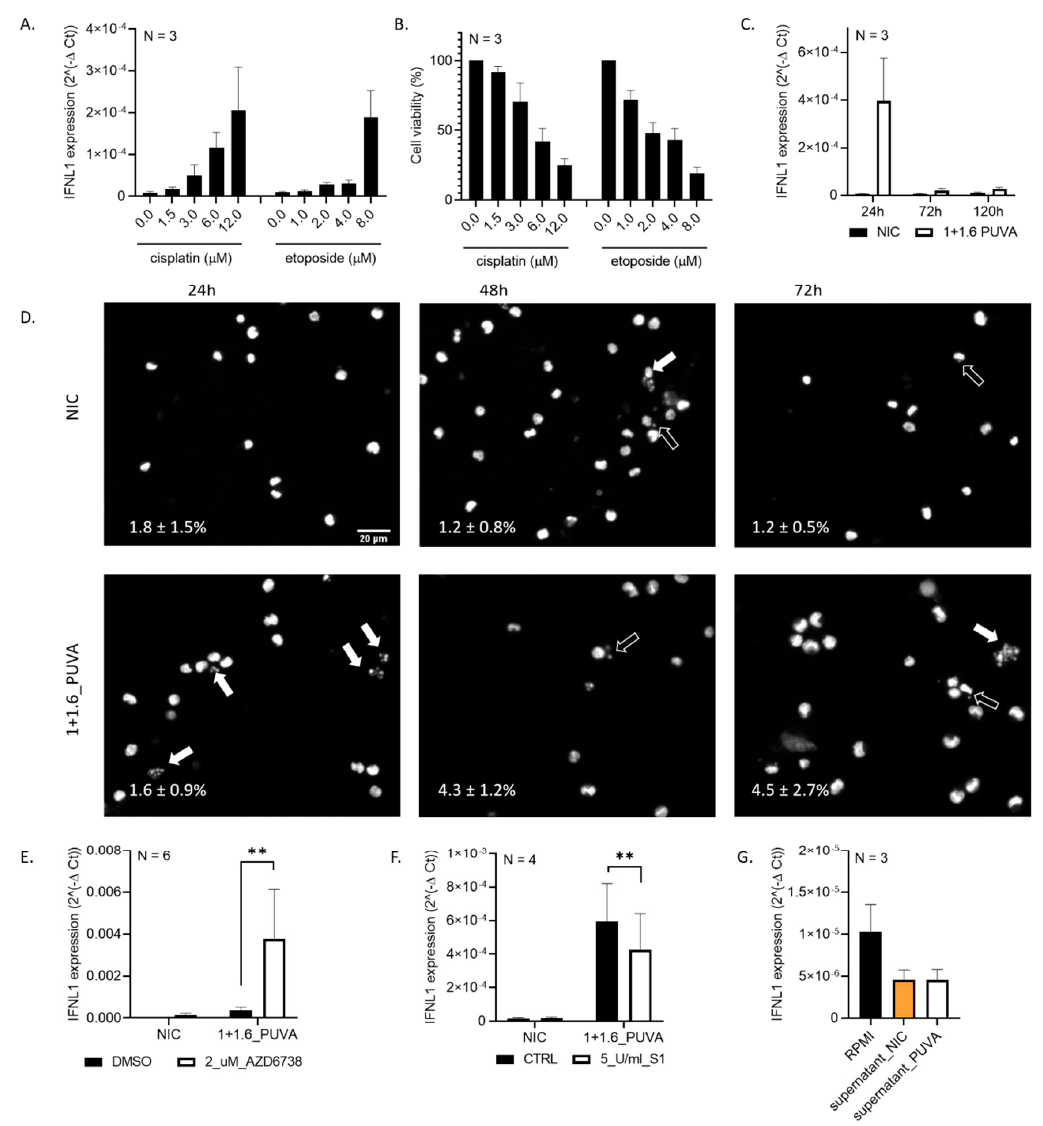
Figure 2. IFNL1 expression in 8–MOP + UVA-treated Hut78 may result from acute DNA damage rather than micronuclei formation. ( A ) IFNL1 expression upon treatment with commonly used genotoxic chemotherapeutics, cisplatin and etoposide. ( B ) Hut78 viability following treatment with cisplatin and etoposide. ( C ) IFNL1 expression in Hut78 following 8–MOP + UVA treatment as a function of time. ( D ) DAPI staining of 8–MOP + UVA-treated Hut78 cells; solid white arrows indicate nuclei of cells undergoing apoptosis; empty arrows indicate micronuclei. Percent of micronucleated cells stated in the bottom-left corner in each photo. ( E ) IFNL1 expression in cells treated with 8–MOP + UVA and ataxia-telangiectasia and Rad3-related (ATR) kinase inhibitor AZD6738; distribution: skewed, test: paired Wilcoxon. ( F ) IFNL1 expression in cells incubated with S1 nuclease, specific for single-stranded DNA (ssDNA) and treated with 8–MOP + UVA; distribution: normal, test: paired t -test. ( G ) IFNL1 expression in Hut78 cells treated with fresh RPMI medium, with supernatant collected from untreated and with supernatant collected from 8–MOP + UVA-treated cells; test: paired t -test. Error bars represent ± SEM of the indicated N repeats. ** p < 0.05.